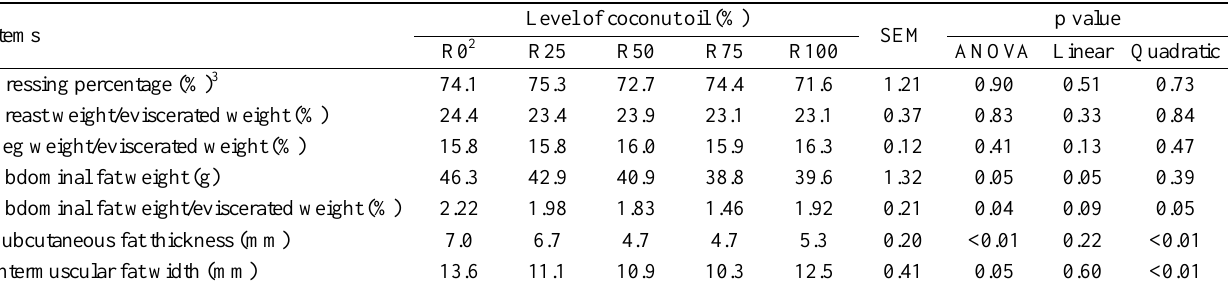
Table 6. Effect of dietary coconut oil as a medium-chain fatty acid (MCFA) source on carcass characteristics of 42-d-old broilers 1